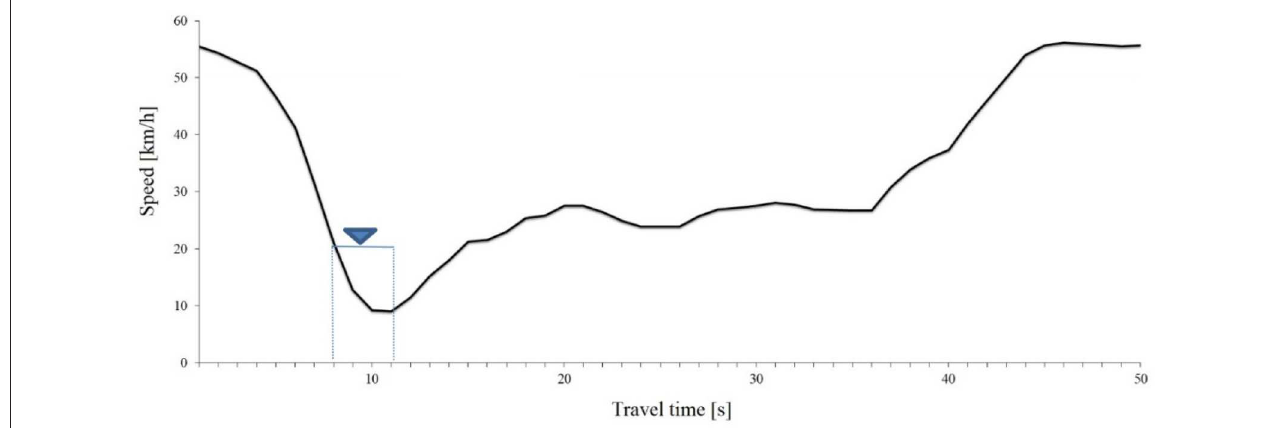
FIGURE 4 | Speed profile for left turn movement at roundabout 1 (South-East movement).